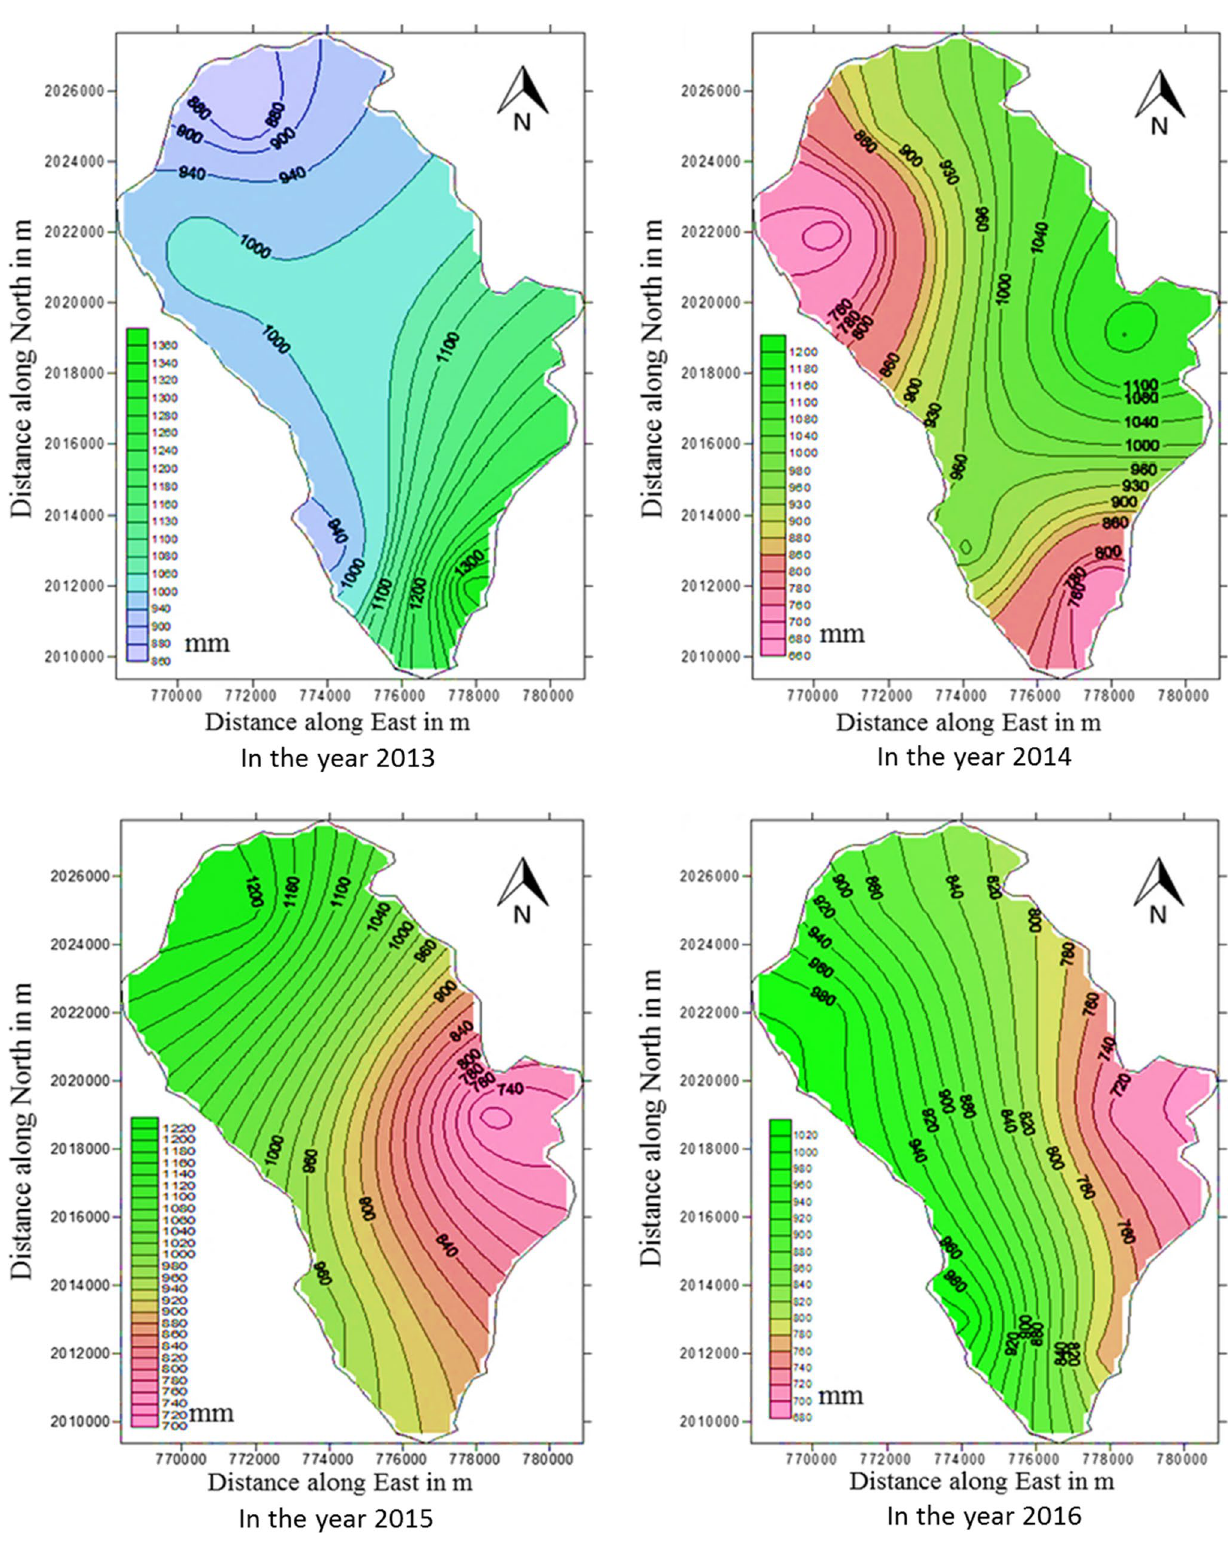
Fig. 5 Contours of monsoon rainfall of Kandivalasa river